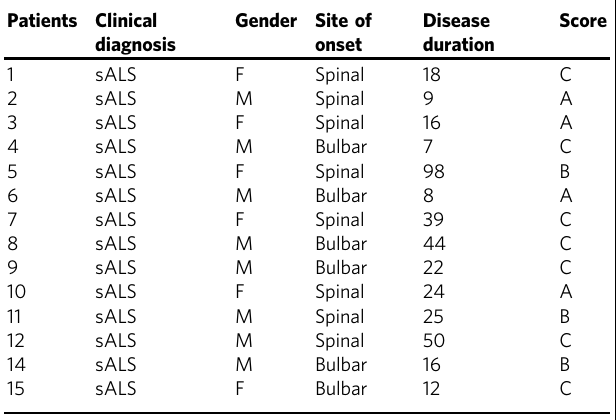
Table 2 List of patients for peripheral blood NK cell analyses. Patients Clinical Gender Site of diagnosis